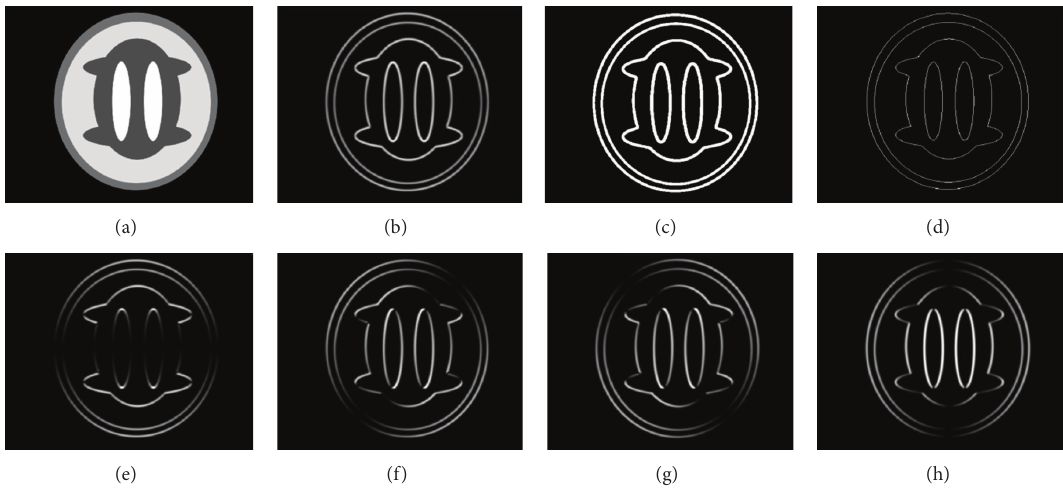
Figure 9: The simulated image and its GWT (𝜎 = 0.24 and 𝜔 = 0.0055) ; (a) original phantom image, (b) GWT, (c) 𝑘 -means, (d) skeleton of (c), (e) 𝜋 /4, (f) 𝜋 /2, (g) 3 𝜋 /4, and (h) 𝜋